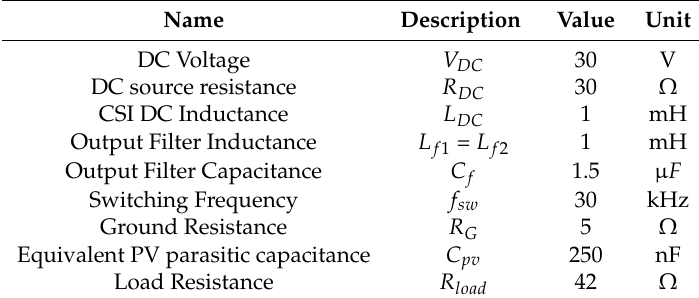
Figure 16. Experimental setup. Table 4. Experimental test-bed